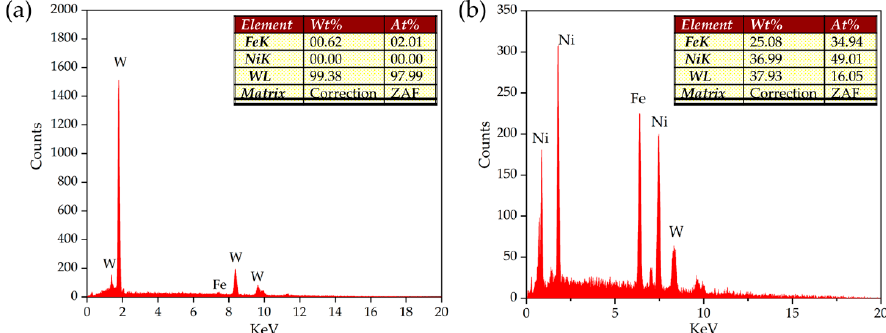
Figure 13. Energy ‐ dispersive spectrometer (EDS) element analysis. ( a ) Point A; ( b ) point B.